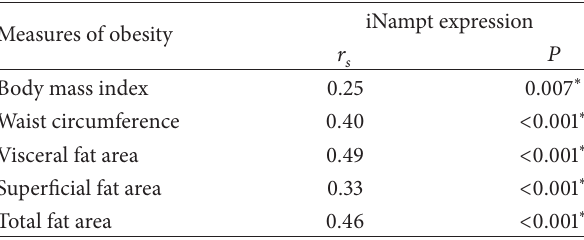
Table 2: Correlations between relative quantification values for iNampt and measures of obesity.